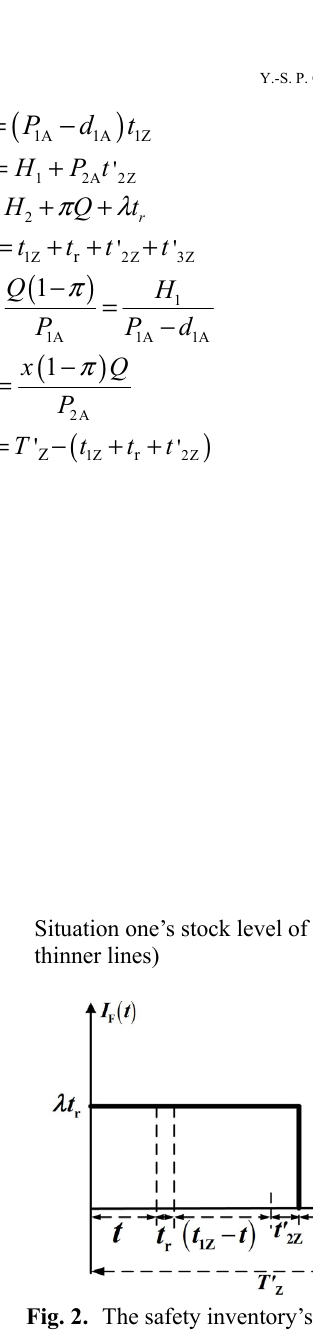
situation 1 during T'